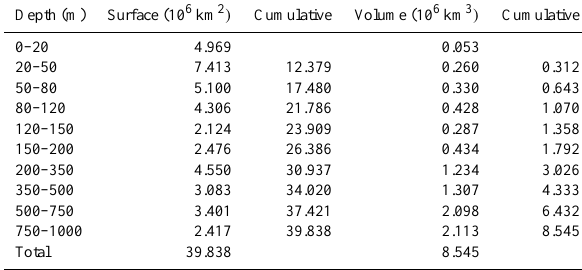
Table 1. Global surface areas and volumes of coastal seas between various isobaths. The integrated values between the shore and the deepest isobaths are also